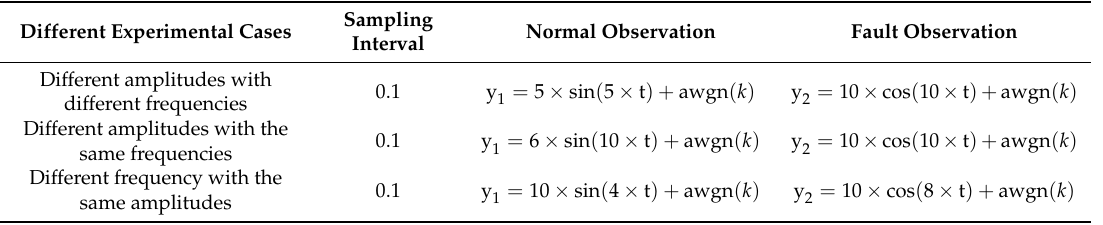
Table 1. Simulation of the data generation scheme.